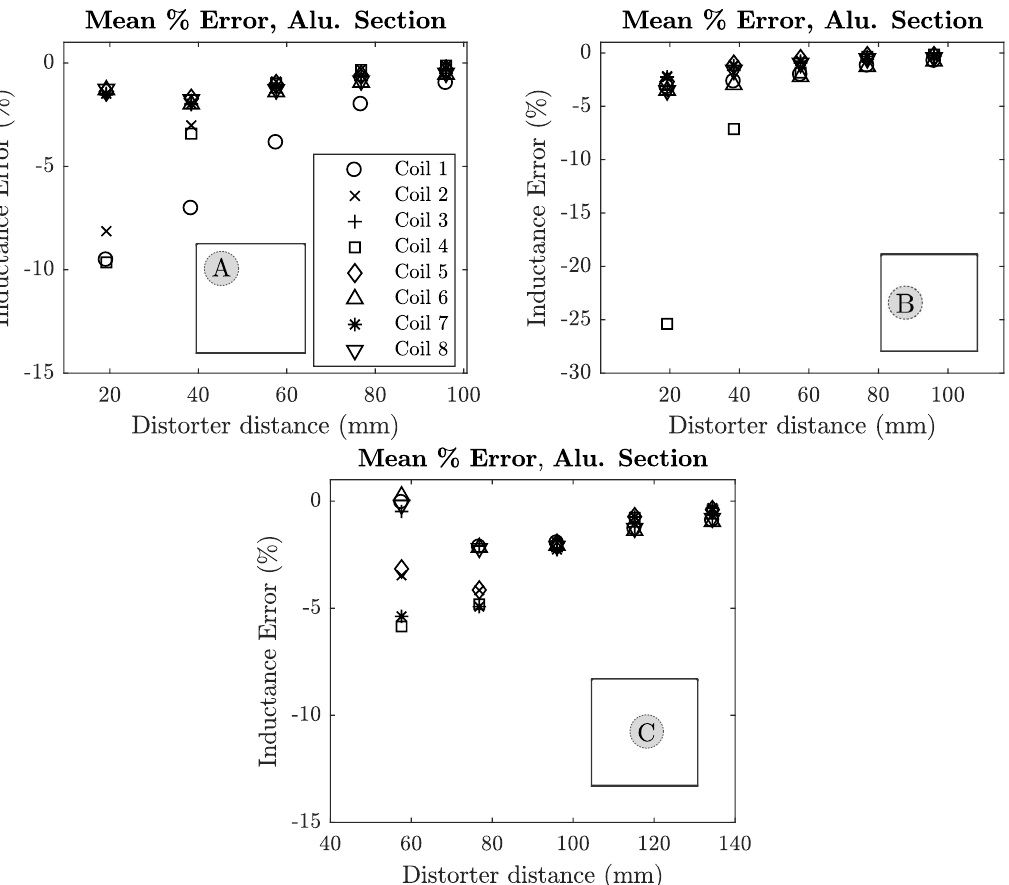
Figure A3. Mutual inductance error for small aluminium block distorter in locations A, B and C. The distorter placed at locations A and B experience the largest errors in their nearest respective coils, 1 and 4. The centrally placed distorter at location C causes the central transmitter coils 2, 4, 5 and 7 to experience the largest mutual inductance